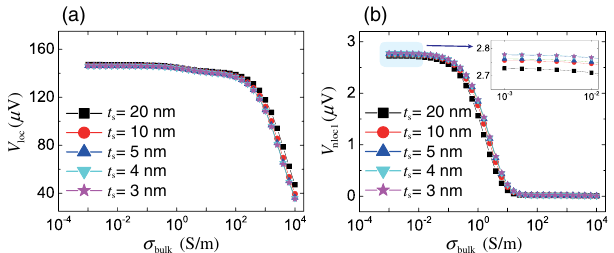
FIG. 8. Surface-channel-thickness dependence of the simula- tion results for (a) V and (b) V , corresponding to loc nloc 1 ð G top Þ ¼ ð 6 . 0 ; 2 . 5 Þð e 2 =h Þ . The inset of (b) represents the bot □ □ ; G magnified view of the marked